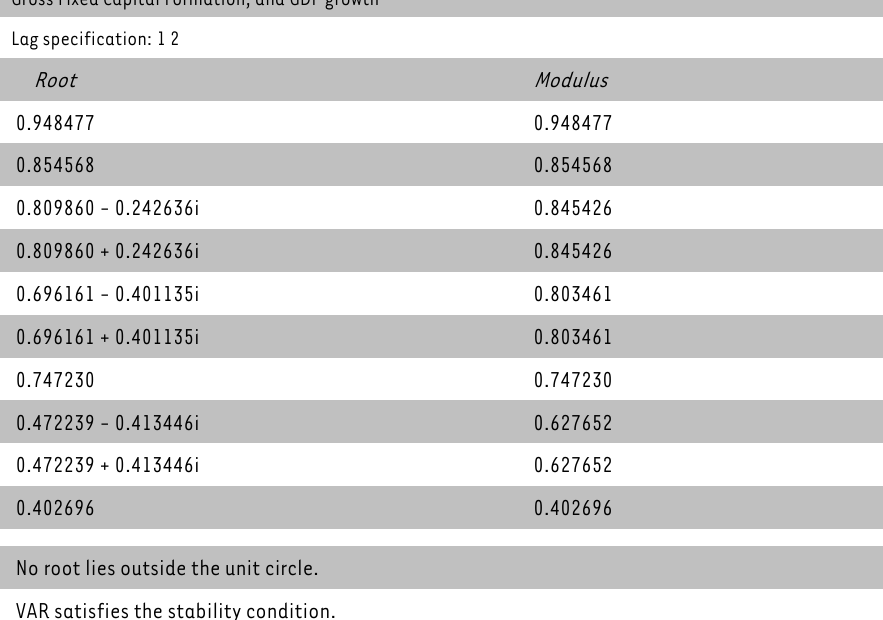
TABLE 4: Roots of characteristic